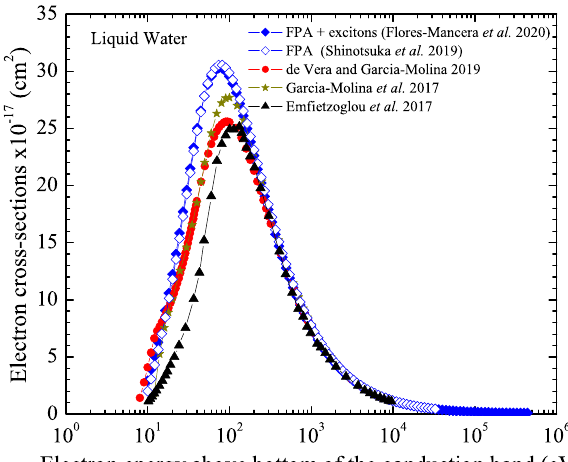
Figure 3. Electron cross-section for liquid water calculated with the FPA by Flores-Mancera et al . with exciton interactions included compared to data published by independent authors.